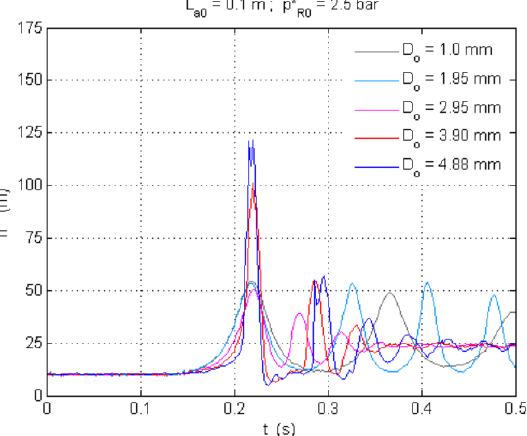
Figure 6. Influence of orifice diameter on the transient behaviour of vented system subject to pipeline filling—five orifice sizes are